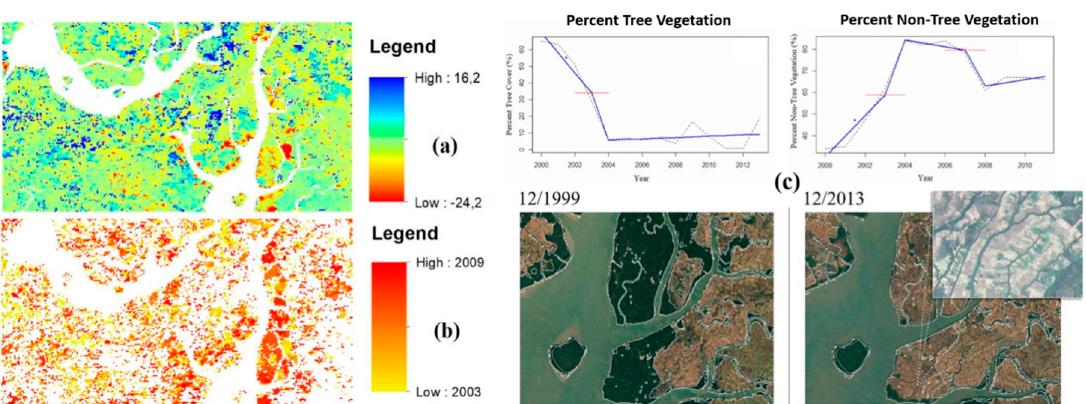
Figure 15. Mangrove deforestation driven by agriculture expansion in Rakhine State, Myanmar. The ( a ) slope and ( b ) breakpoint maps are produced by annual percentage of tree cover (PTC) and percentage of non-tree vegetation (PNTV) (MOD44B) data from 2000 to 2013 using the green-brown and bfast package in R [85,87]. ( c ) shows the breakpoint detection processed by annual PTC and PNTV (MOD44B) data from 2000 to 2013 using the bfast package in R [85] and a land cover comparison before deforestation in 1999 (left) and after deforestation in 2013 (right) using the Google Earth archives.